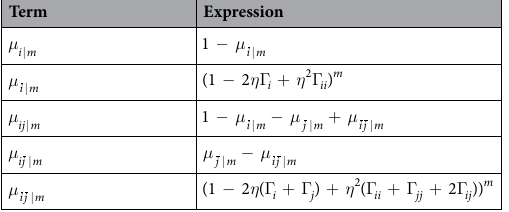
and coincidence µ conditioned on the number of photon pairs | p m | pq m